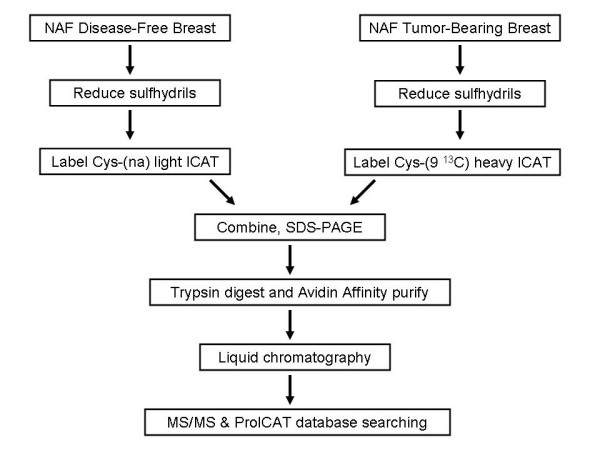
Schema of ICAT analysis performed using a Cleavable ICAT Reagent Kit (Applied Biosystems, Foster City, CA) according to the manufacturer's guidelines, with some modifications. Avidin Affinity refers to the Avidin Affinity Cartridge kit (Applied Biosystems, Foster City, CA)